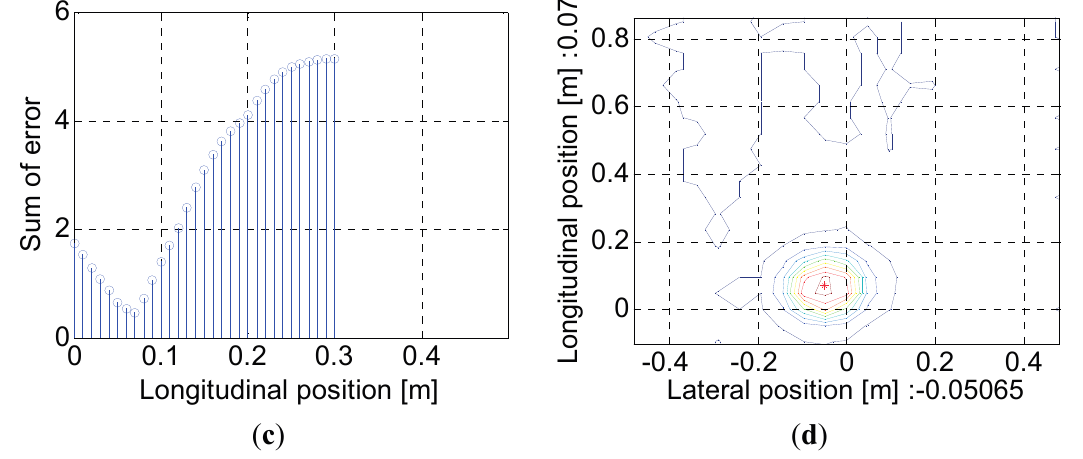
Figure 10. Results of peak detection using the algorithm for compensation of time delays: ( a ) Lateral position detection; ( b ) Longitudinal position detection; ( c ) Error calculations in longitudinal position detection; ( d ) Real-time detection of magnetic markers using 2D positional